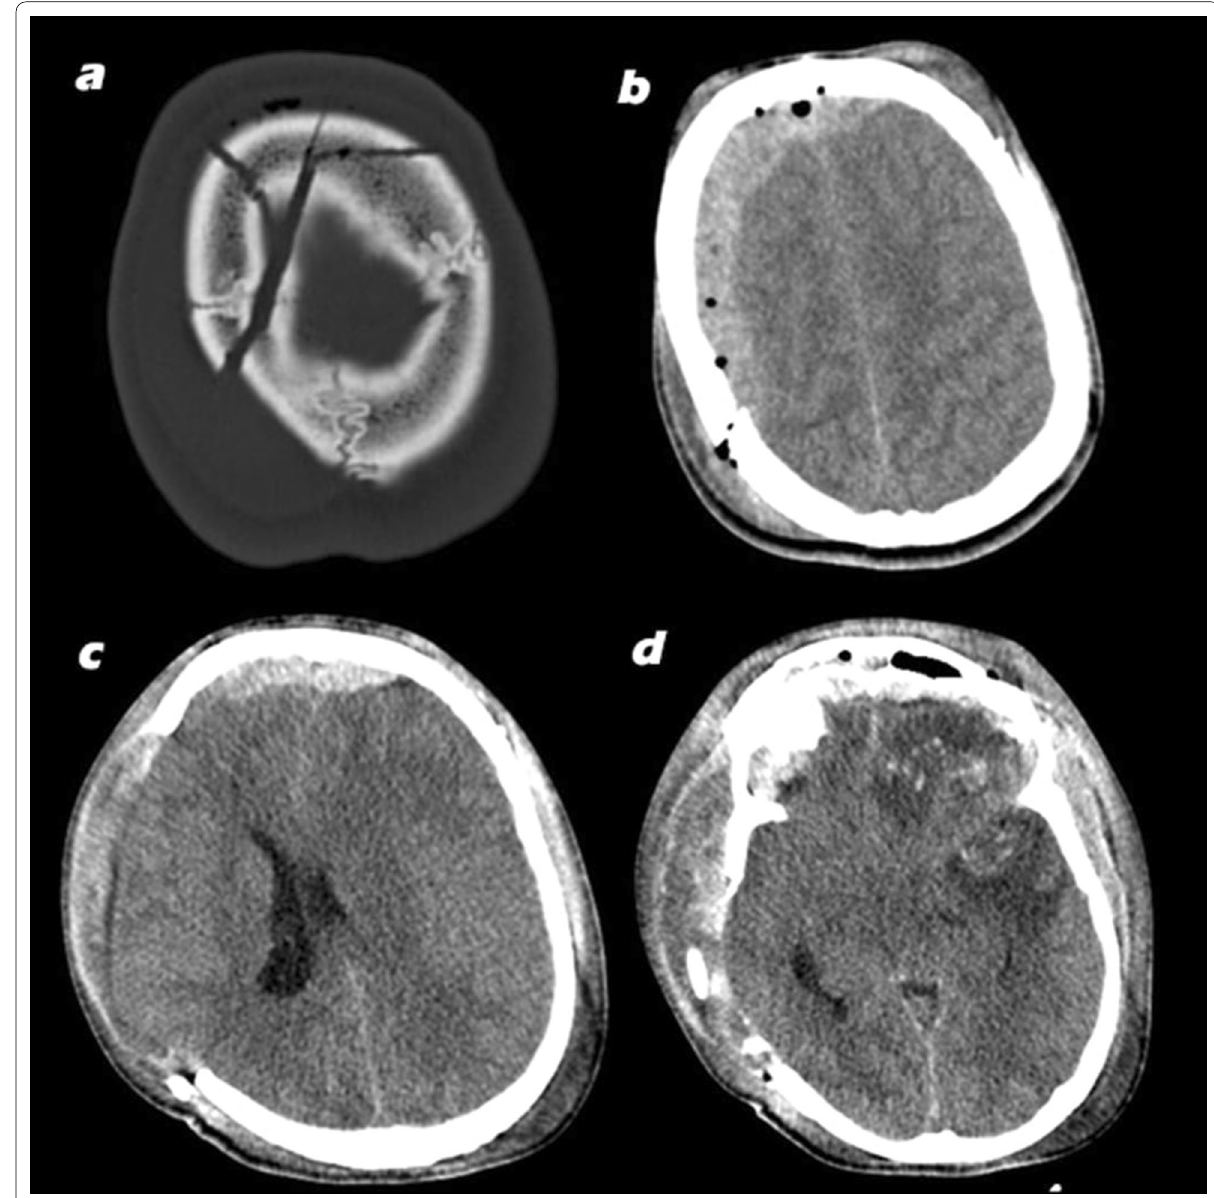
Fig. 3 a Fracture of right parietal bone extending through coronal suture to bilateral frontal bones; b extra-axial hematoma extending from midline, mainly on right side with pneumocephalus; c CT after decompressive craniectomy showing edema; d left frontotemporal contusions